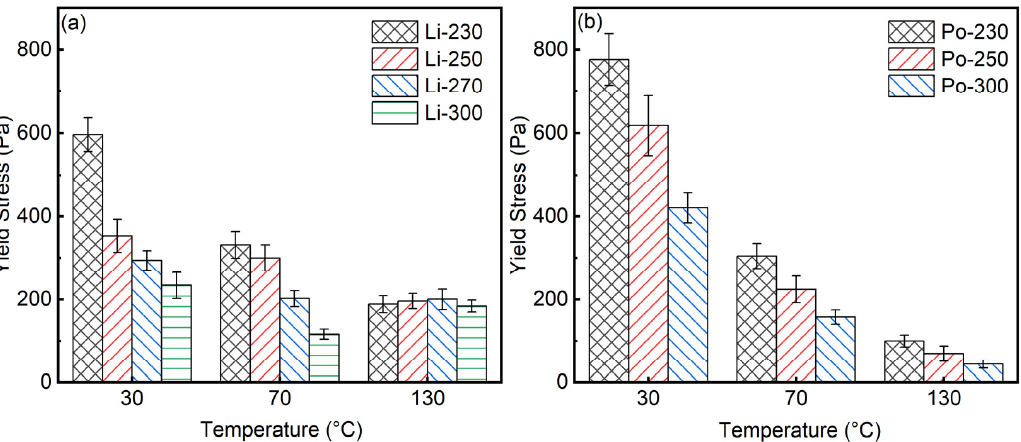
Figure 10. Yield stress τ y of greases under steady-state test conditions: ( a ) lithium grease, ( b ) polyurea grease.